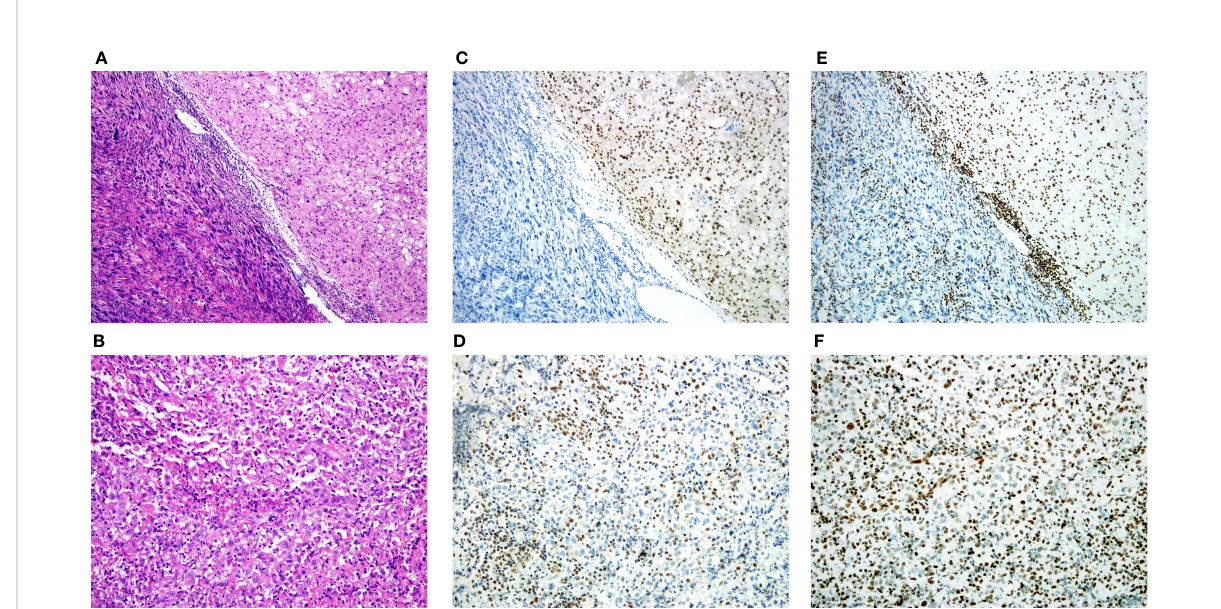
FIGURE 2 H3K27me3 expression in dedifferentiated chordoma and poorly differentiated chordoma tissues. (A) Dedifferentiated chordoma with typical features of conventional chordoma (right), and a transition to a high-grade pleomorphic sarcoma (left). (B) Poorly differentiated chordoma. (C) IHC staining of brachyury, noting that the dedifferentiated component did not express brachyury. (D) IHC staining of SMARCB1 (INI1), and the poorly differentiated chordoma showed loss of SMARCB1 (INI1). (E, F) IHC staining of H3K27me3, (E) Low expression of H3K27me3 in dedifferentiated component, (F) High expression of H3K27me3 in poorly differentiated